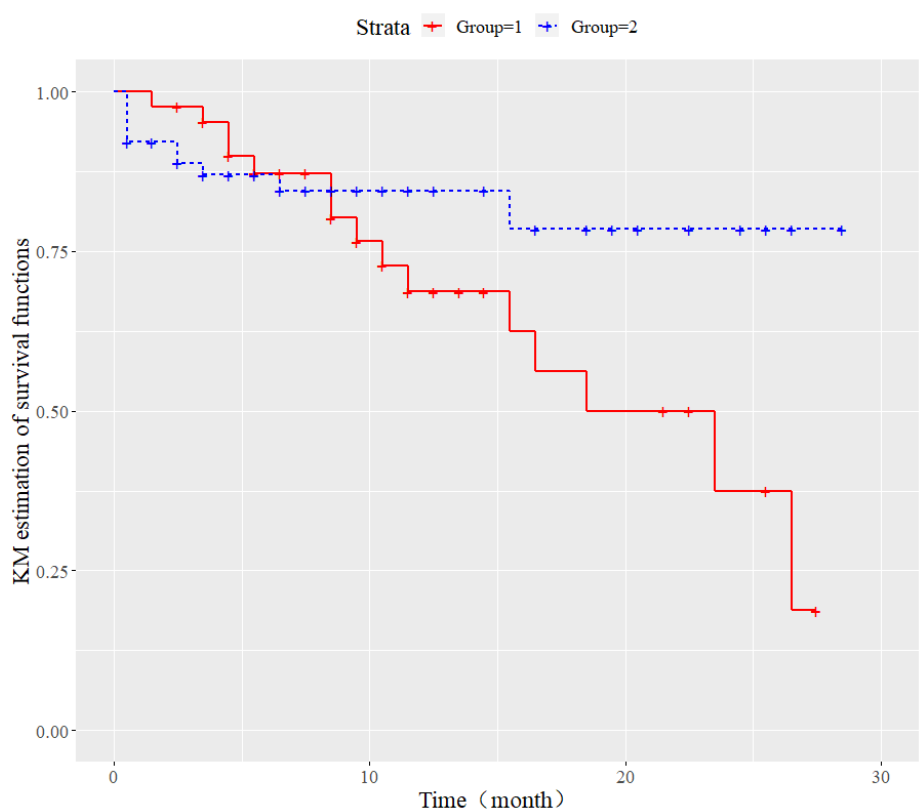
Figure 8. Kaplan–Meier curves of time to infection of kidney dialysis